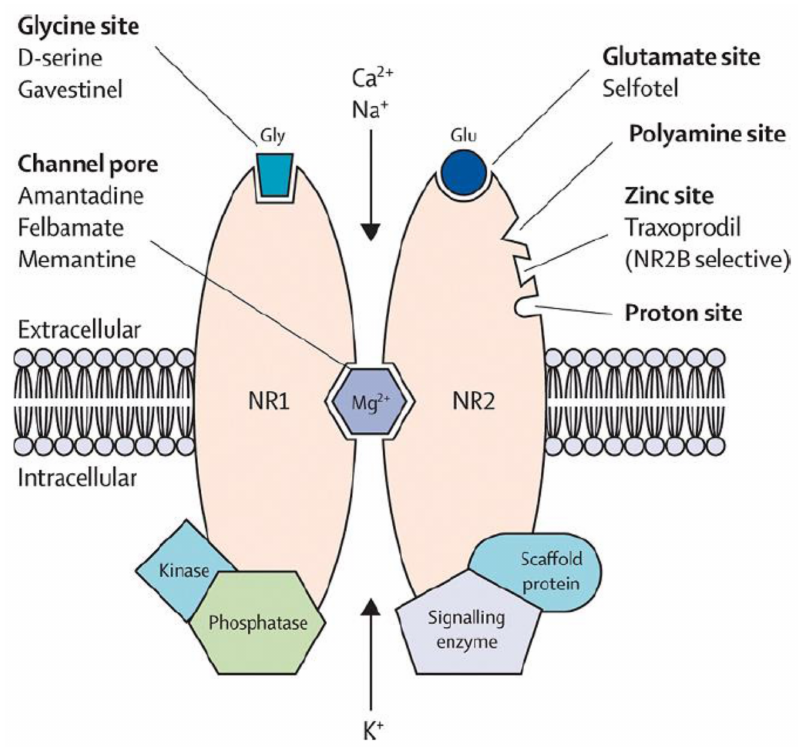
Figure 1. Glutamatergic N -methyl- D -aspartate receptor with magnesium block of calcium channel. Reprinted from [8] with permission from